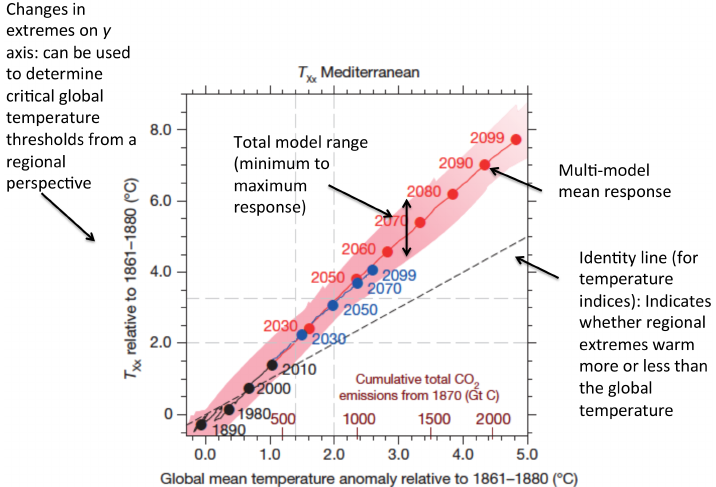
Figure 1. Example of a plot displaying the functional relationship of a regional climate index (annual maximum of daily maximum temper- ature, T Xx ) on global mean temperature following the S16 approach, including explanatory annotations (adapted from